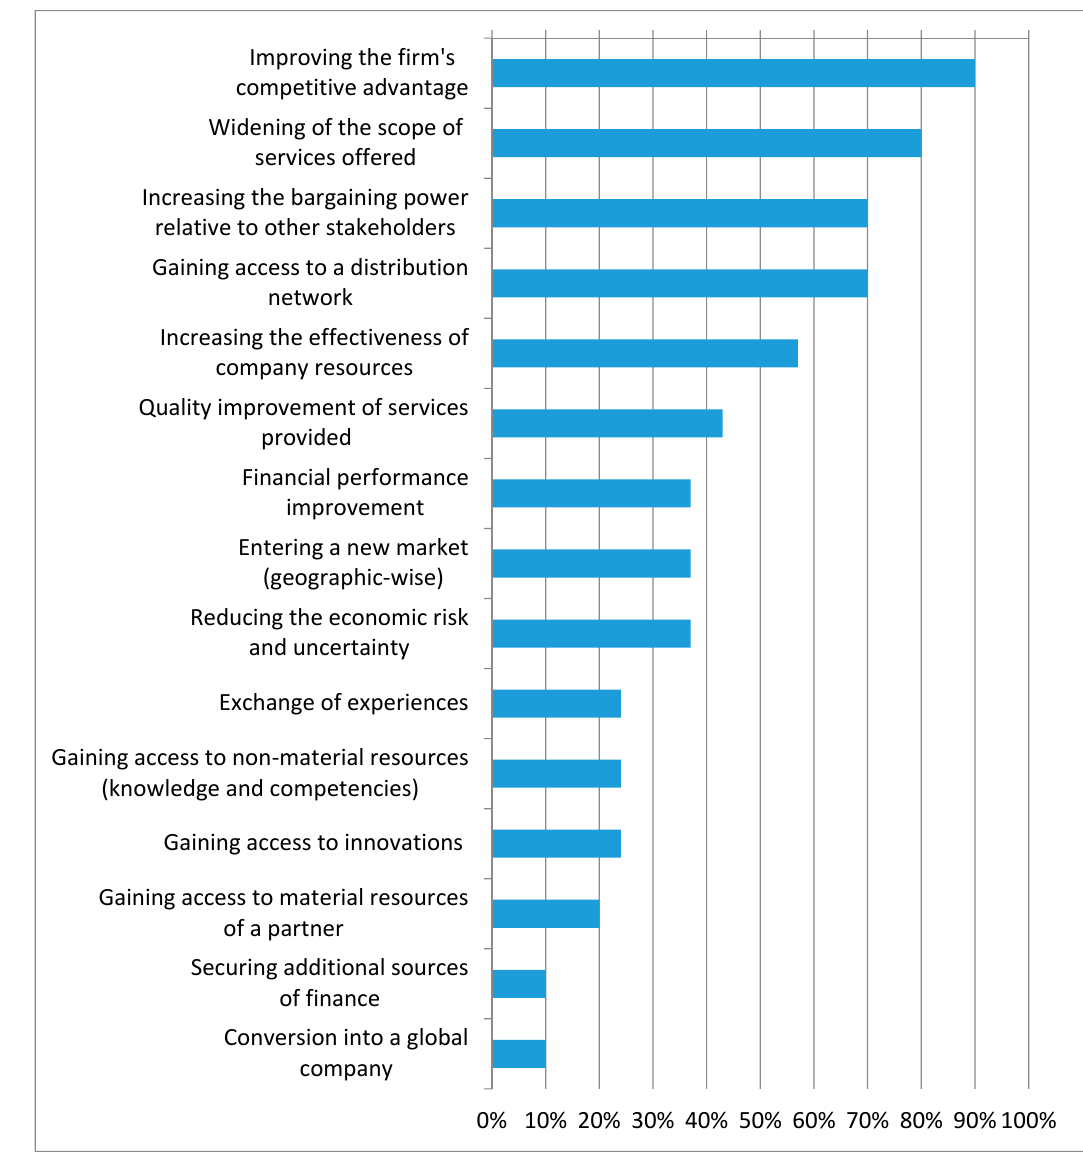
Figure 5. Objectives of forming strategic alliances as declared by Polish firms.